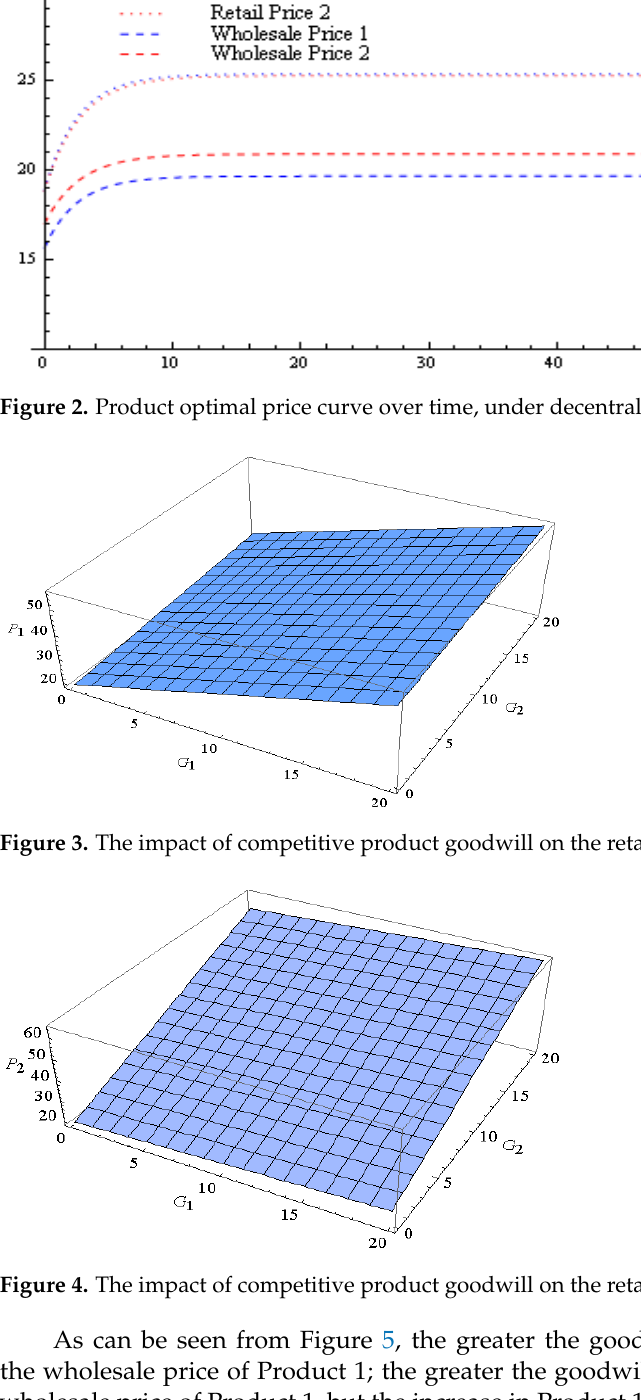
Figure 4. The impact of competitive product goodwill on the retail price of Product 2.